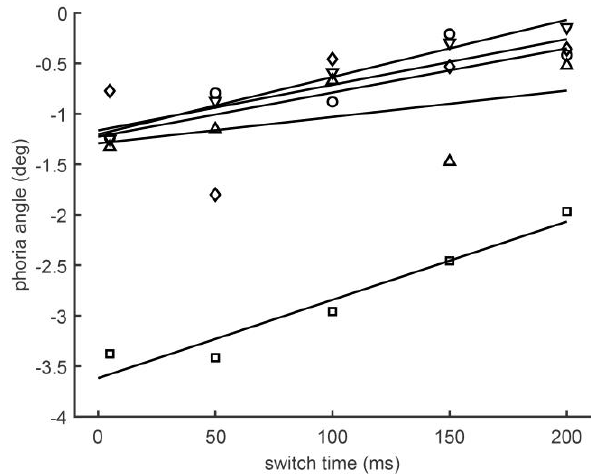
Figure 3: The symbols depict the phoria angles of the five subjects, and the lines the corresponding five linear regressions. The regression slopes (4.99 ± 1.90deg/s) differed significantly from zero (p < 0.05).